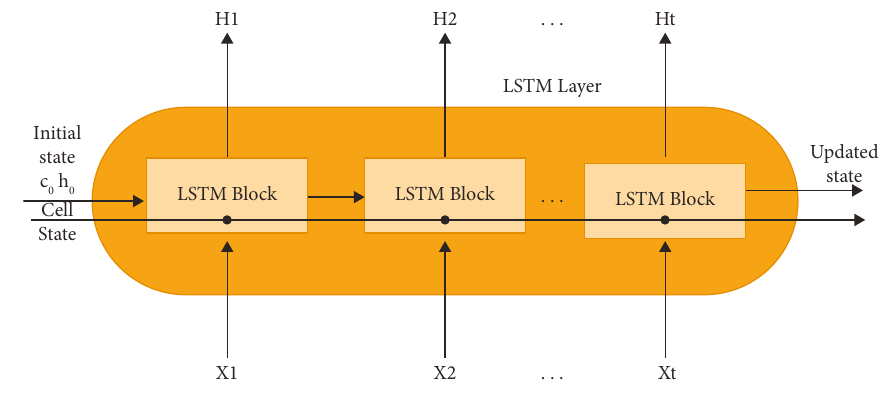
Figure 10: Working of LSTM.